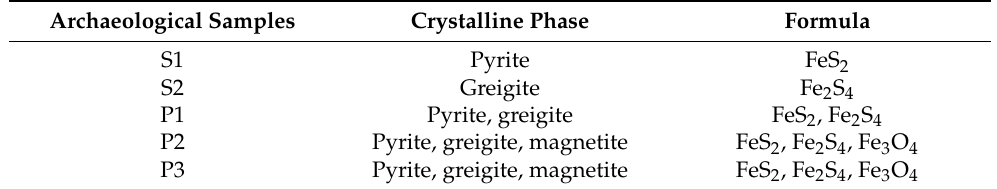
Table 3. Main crystalline phases identified via Xray